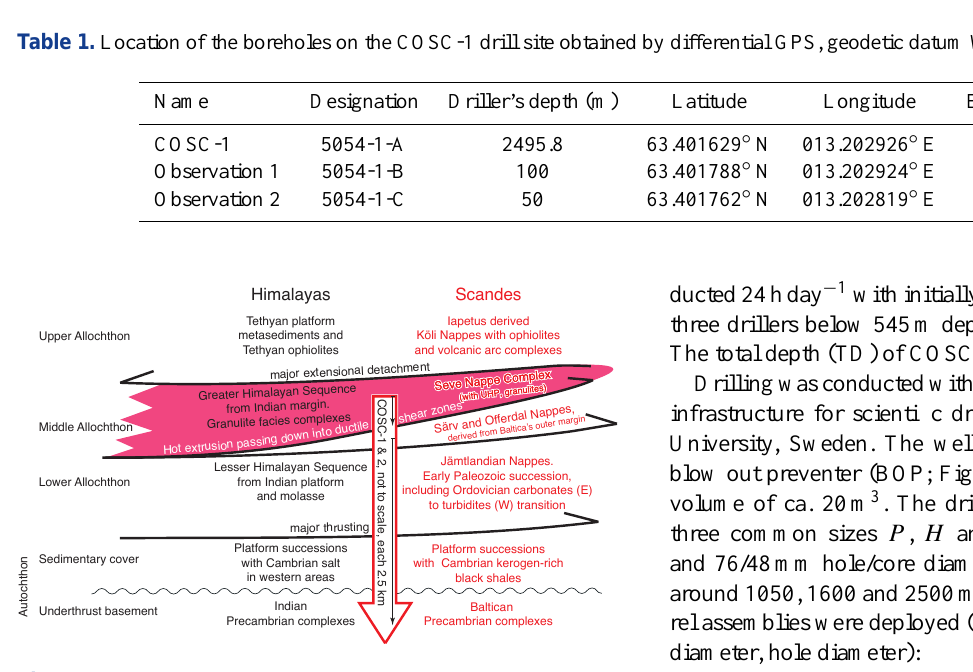
Figure 3. Schematic comparison of tectonostratigraphic units be- tween Himalayas and Scandes with COSC-1 and COSC-2 indi-